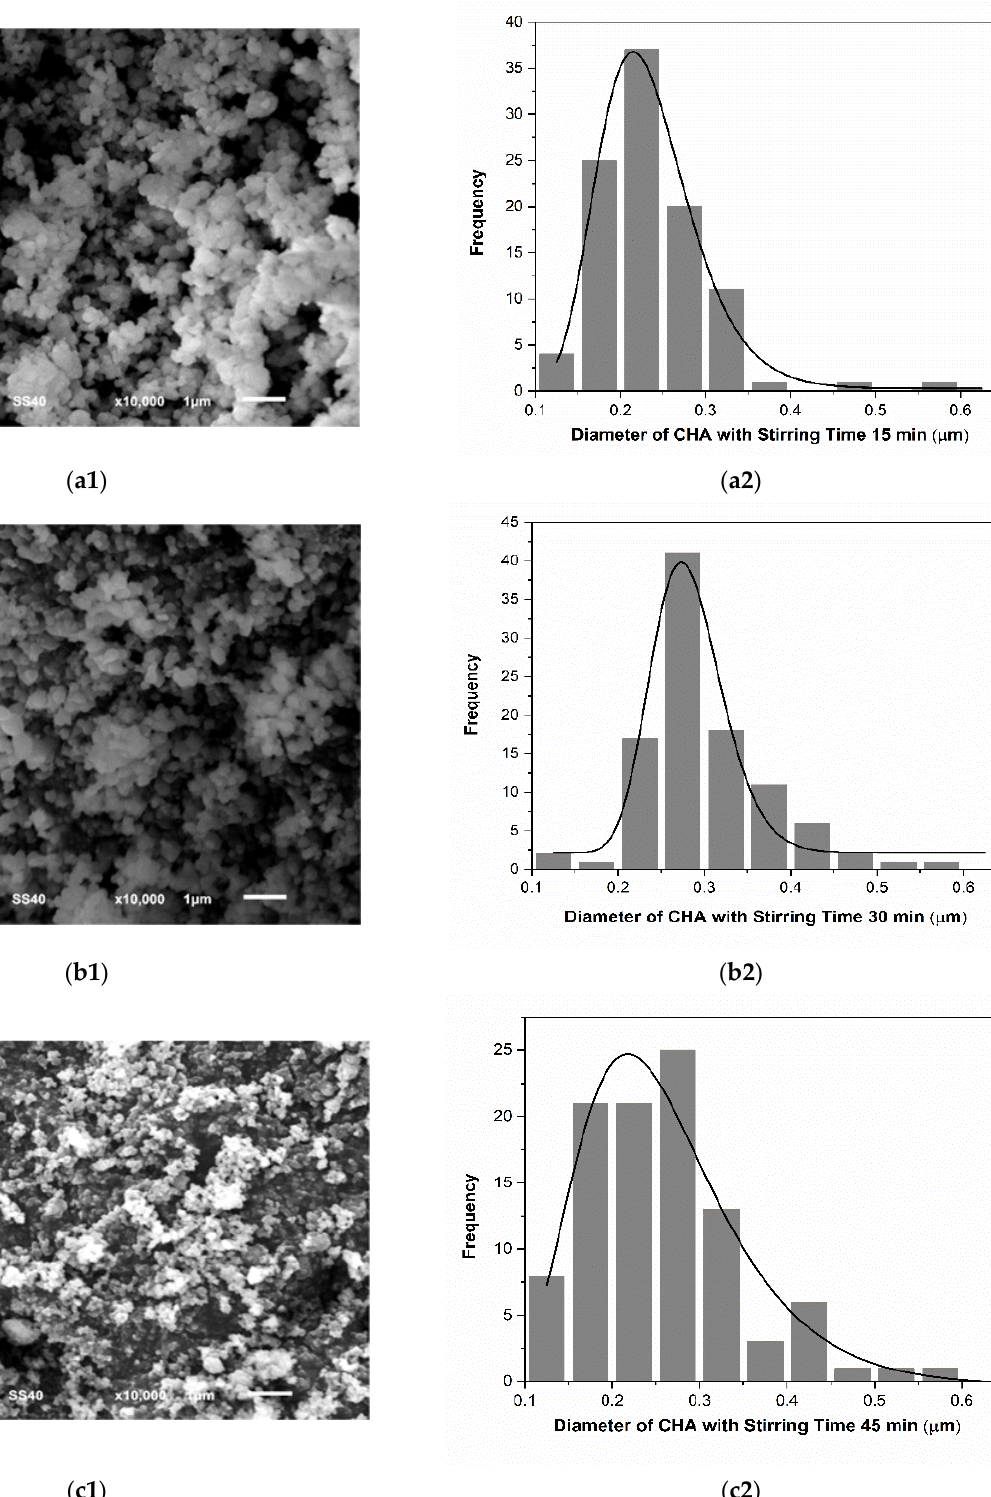
Figure 2 . Morphology and particle size distribution of CHA with stirring times of: ( a1 , a2 ) 15 min; ( b1 , b2 ) 30 min; ( c1 , c2 ) 45 min.